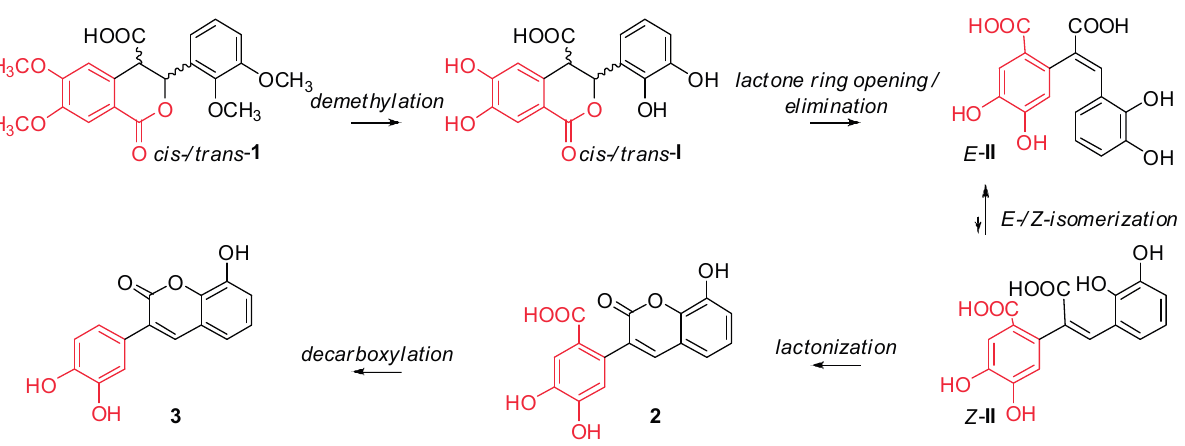
Scheme 2. Proposed reaction mechanism for synthesis of 3-arylcoumarin 3